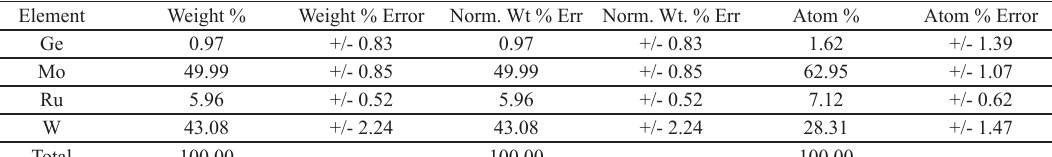
Table 6. SEM quantitative EDS specimens results.